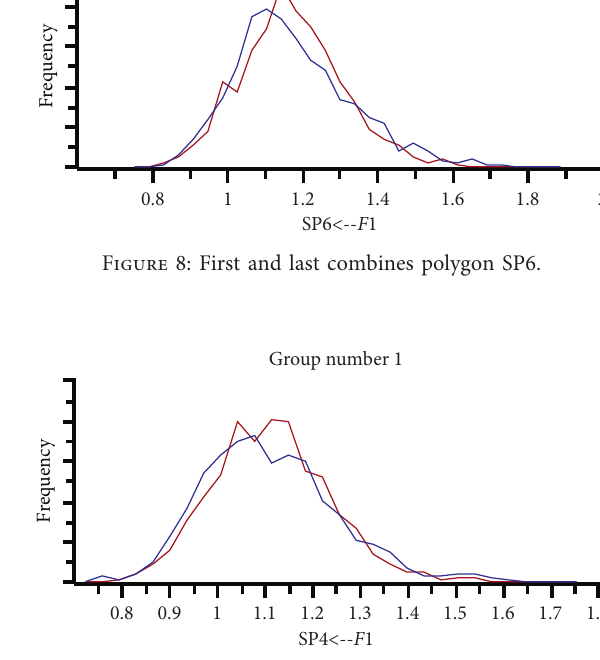
Figure 9: First and last combines polygon SP4.